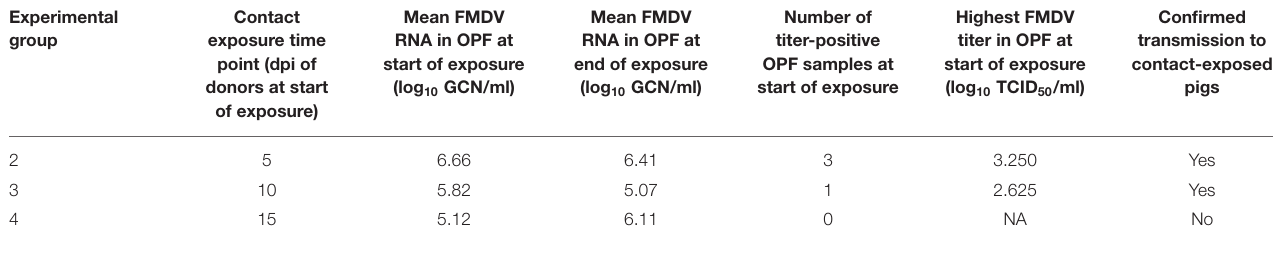
TABLE 1 | Donor pig characteristics during contact exposure periods. Experimental group